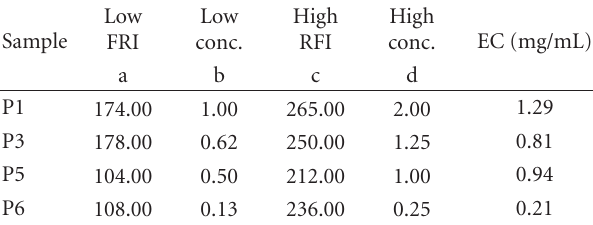
Table 2: E ff ects of EC 200 on biodegradable polymers.